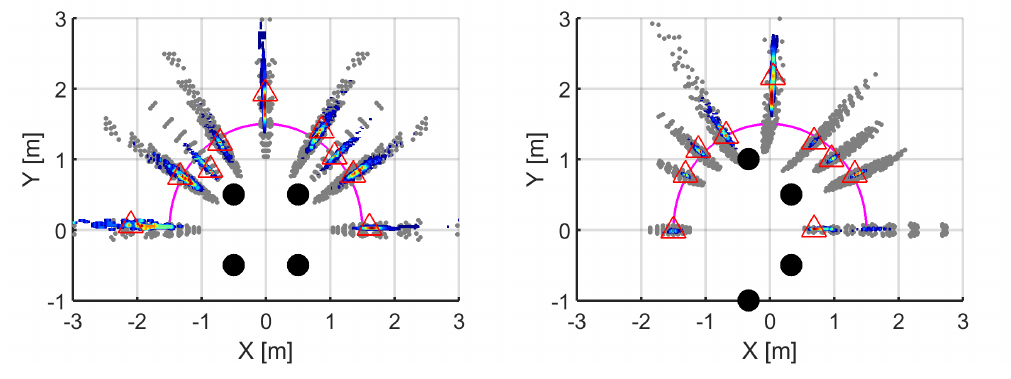
Figure 4. Simulated and experimental results for the squared and trapezoidal